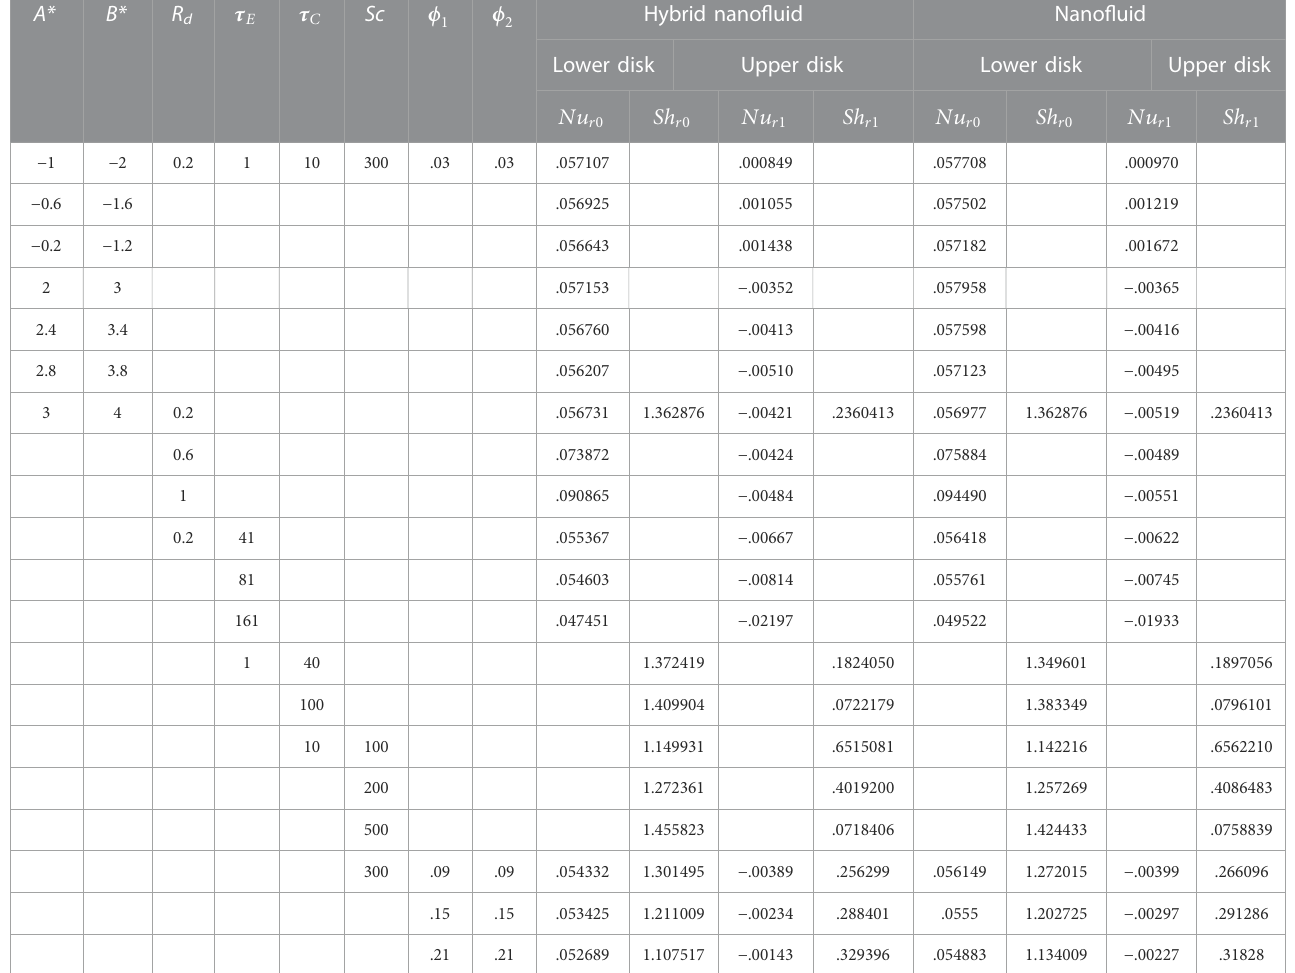
TABLE 3 Numerical values of the heat transfer coef fi cient and Sherwood number when Pr (cid:2) 6 . 2